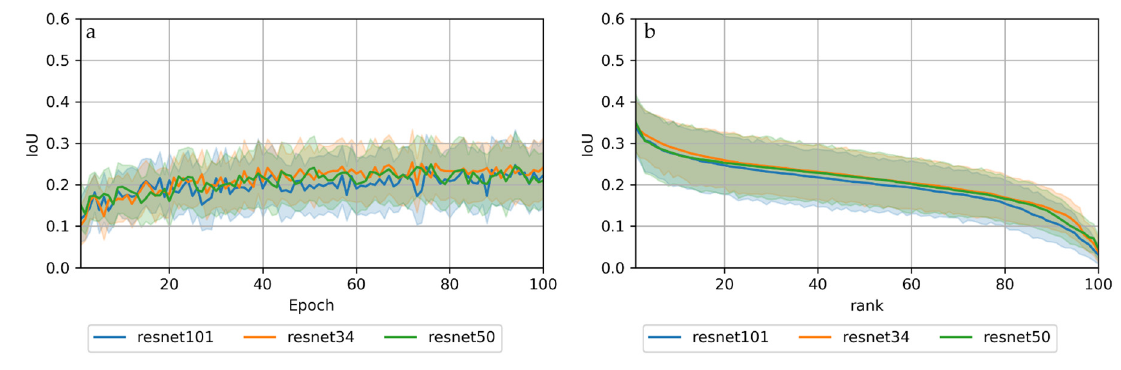
Figure A9. Study site Tuktoyaktuk. ( a ) ESRI satellite layer, ( b ) ArcticDEM superimposed with hillshade, ( c ) Tasseled Cap trend visualization, ( d ) PlanetScope satellite image (NIR-R-G) acquired on 13 July 2019. Blue box, 10 × 10 km study site. Red box detailed view of ( d ).